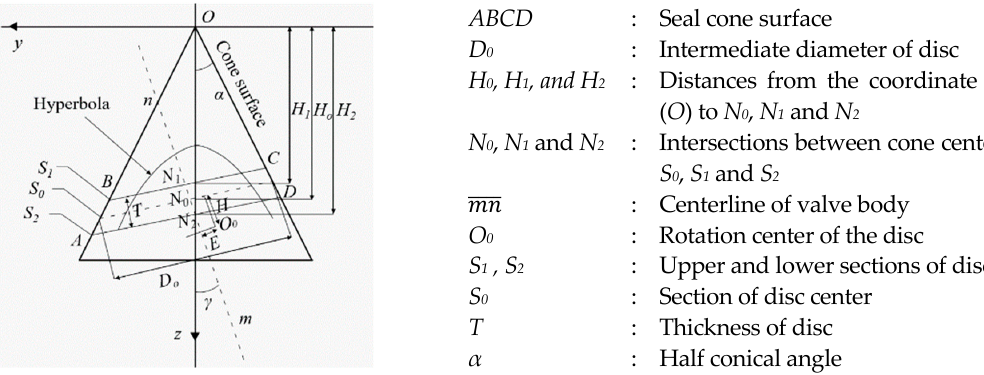
Figure 6. Geometry of triple offset seal pair.